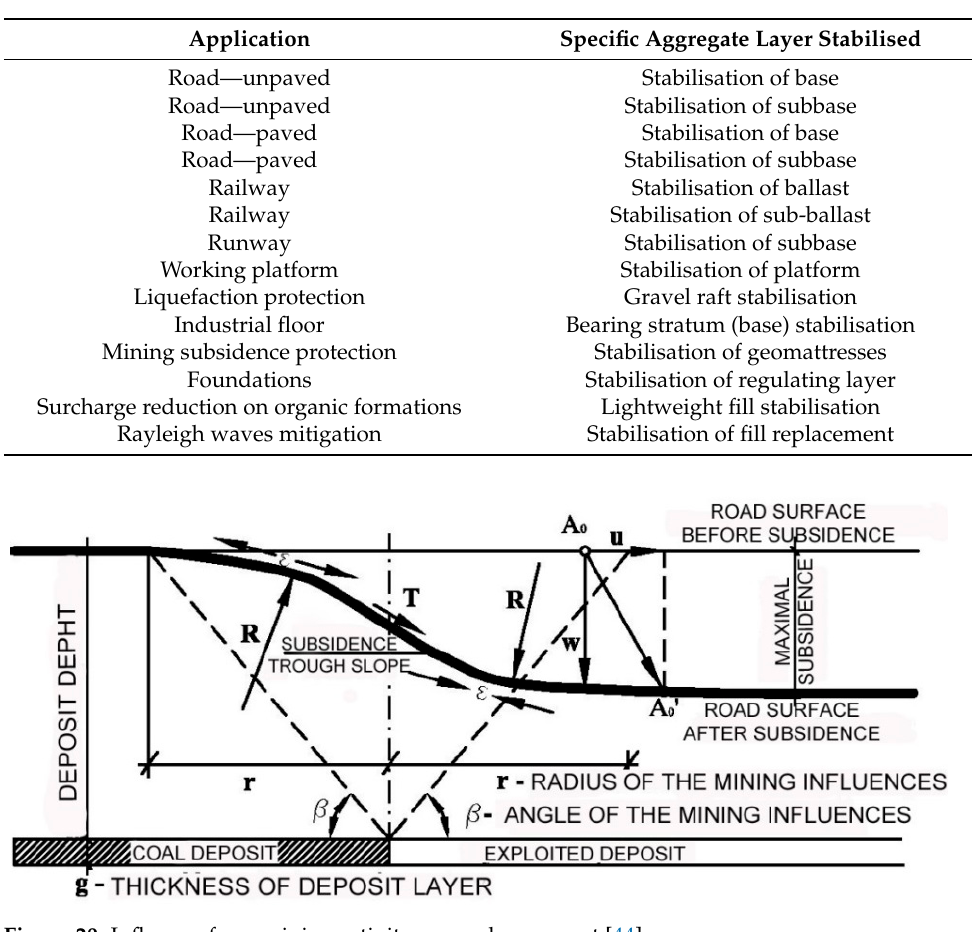
Figure 21. Example of geomattress formed from geogrids and recycled aggregate (mining wastes).